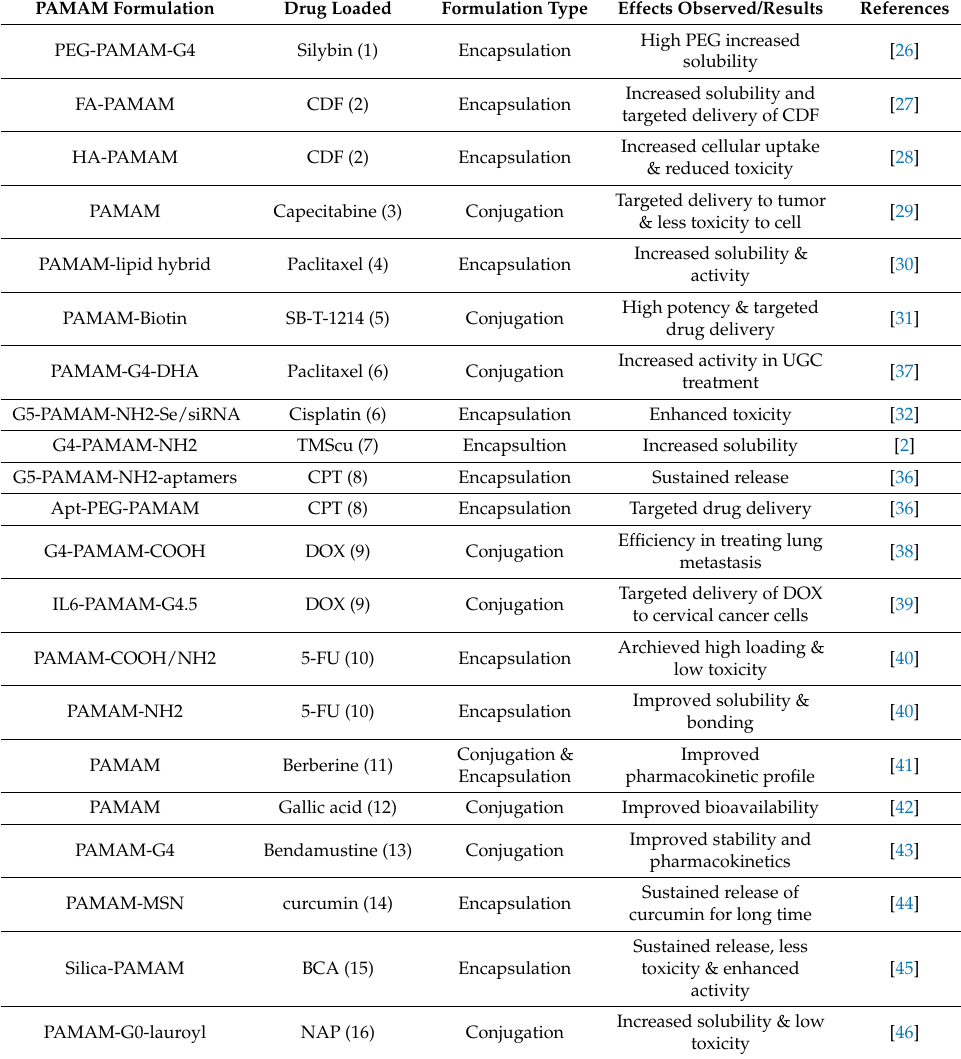
Table 1. Some examples on the effect of polyamidoamine (PAMAM) dendrimer surface modification on improvement of solubility, biodistribution, and targeted drug delivery of small